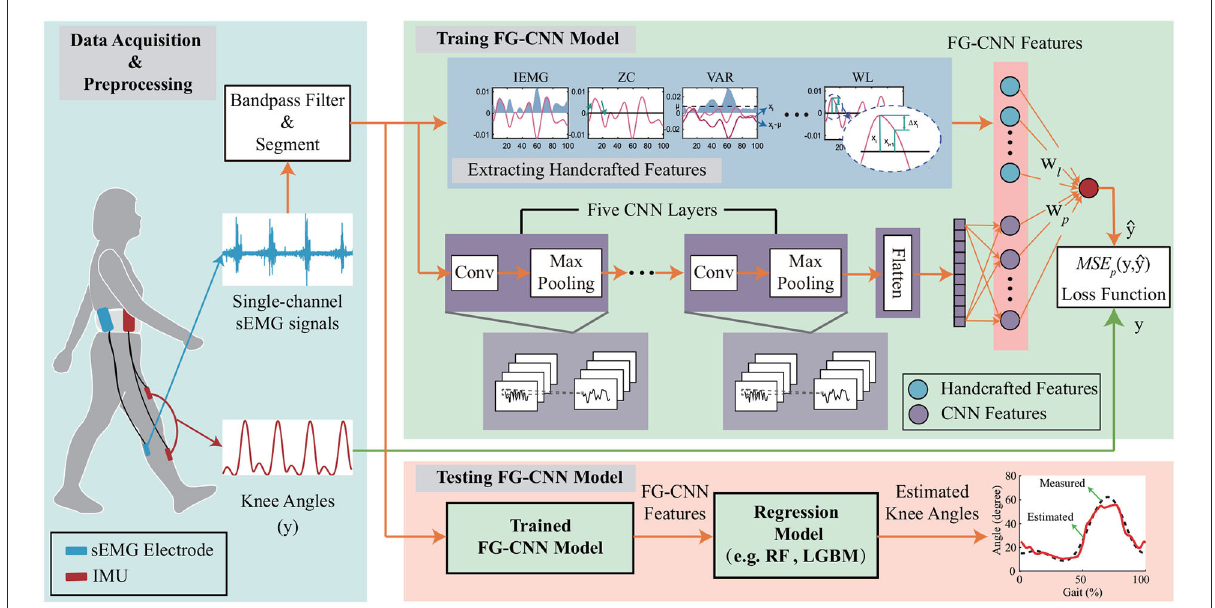
FIGURE1 The overall framework of the FG-CNN-based motion estimation. The FG-CNN consists of the operation of extracting handcrafted features, five CNN layers, one flatten layer, and one fusion layer for fusing CNN features and handcrafted features. IMU represents the inertial measurement unit; Conv denotes the convolutional layers; IEMG, VAR, ZC, and WL represent the handcrafted features. The symbols w l and w p , respectively, represent the weights of the handcrafted and CNN features in the fusion layer. RF and LGBM represent the random forest model and light gradient boosting machine, respectively.